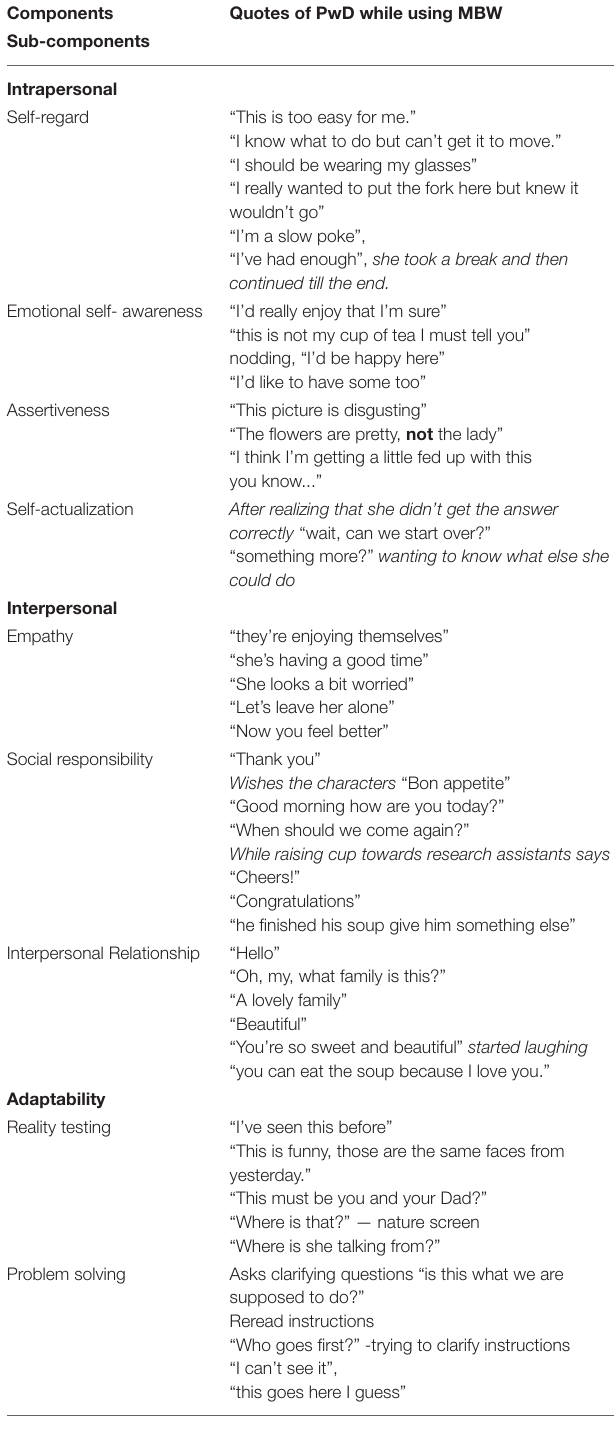
TABLE 3 | Quotes demonstrating selected sub-components of Bar-On’s model of emotional social